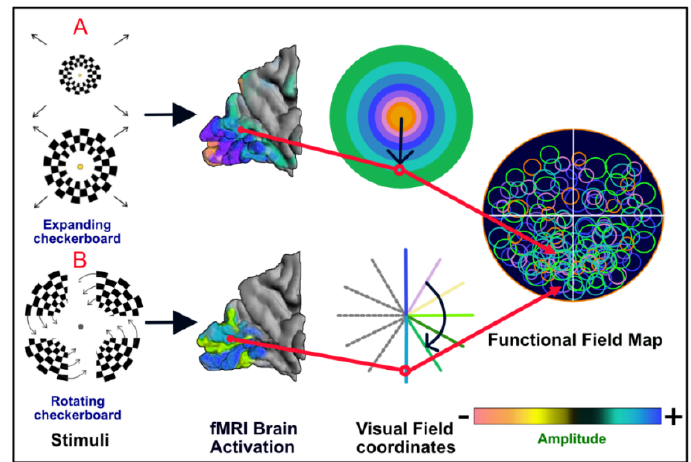
Figure 6. Stimuli for visual field mapping and construction of functional field maps (FFMaps). Retinotopic mapping stimuli consist of an expanding black and white checkerboard ring ( A ) or a rotating checkerboard wedge ( B ). The patient was asked to stare at the yellow dot in the center while the rings of flickering stimuli were outside of his/her visual field ( A ) to separate the signal from the fovea from the periphery of the visual field.